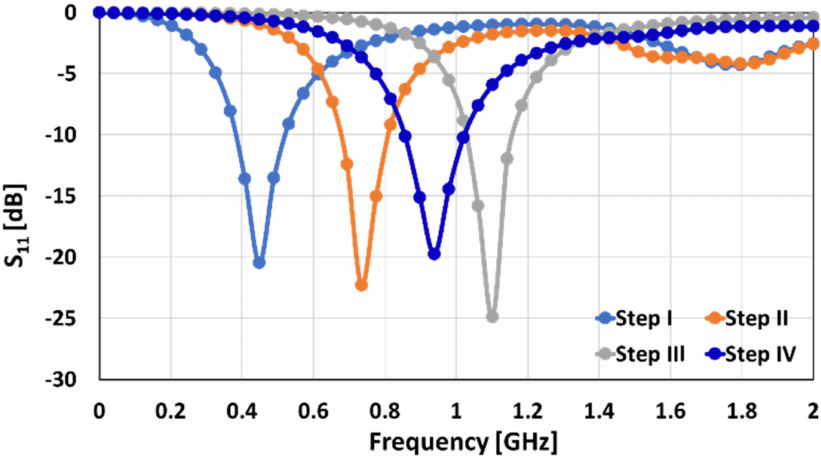
Figure 4. S 11 comparison of the corresponding antenna designing steps.